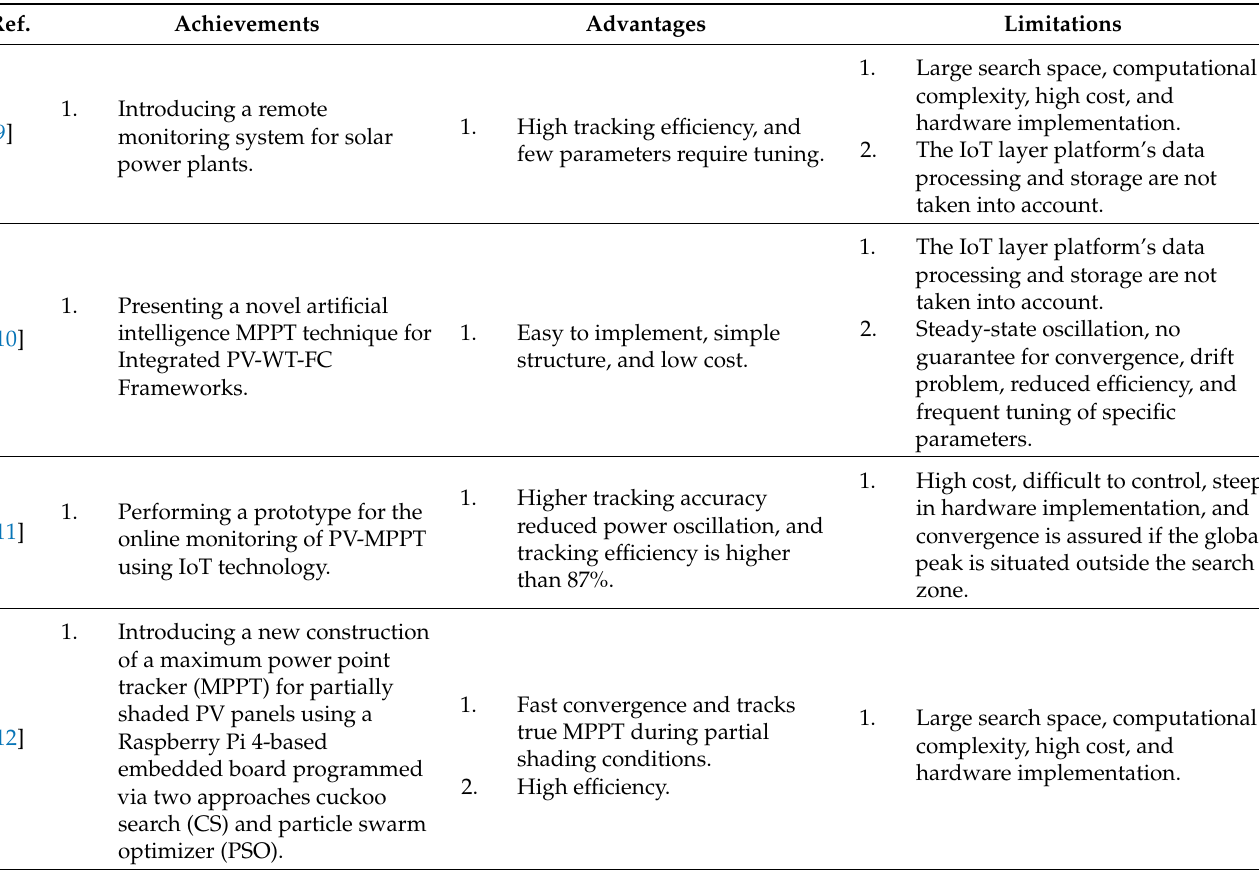
Table 1. Summary of the benefits and drawbacks of some MPPT